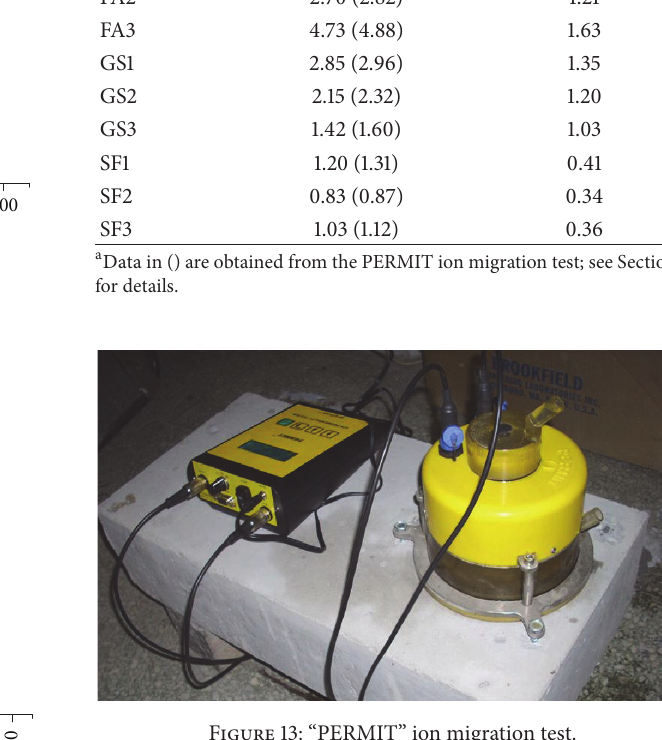
Figure 13: “PERMIT” ion migration